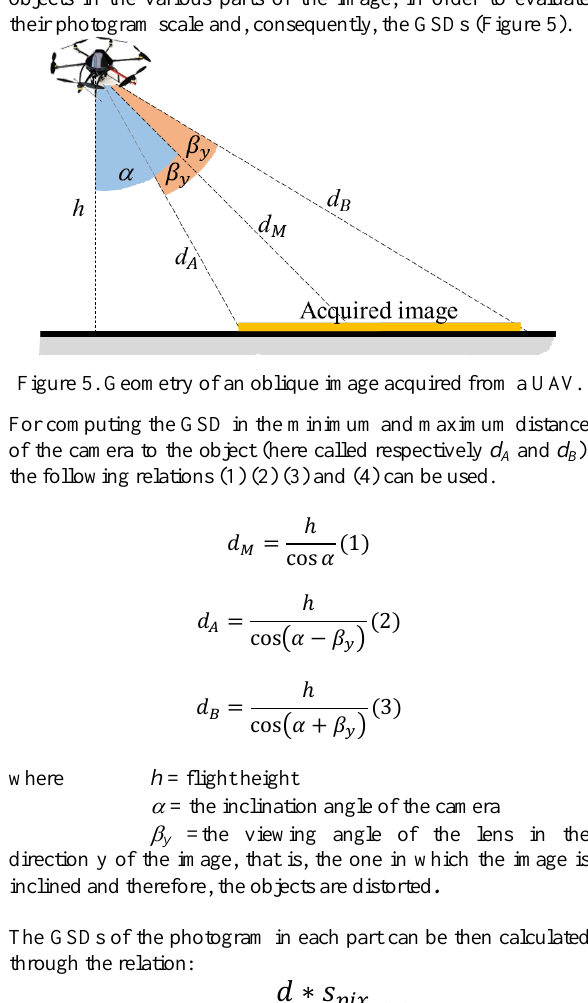
Table 2. GSDs in the various parts of the oblique photograms